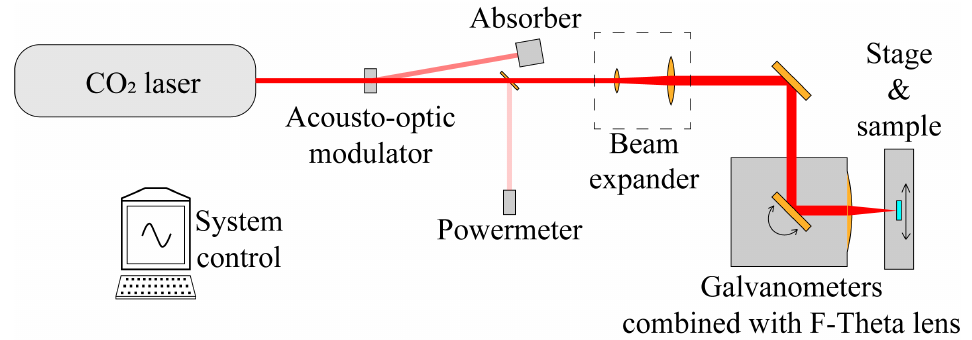
Figure 1. Experimental setup for laser scanning.